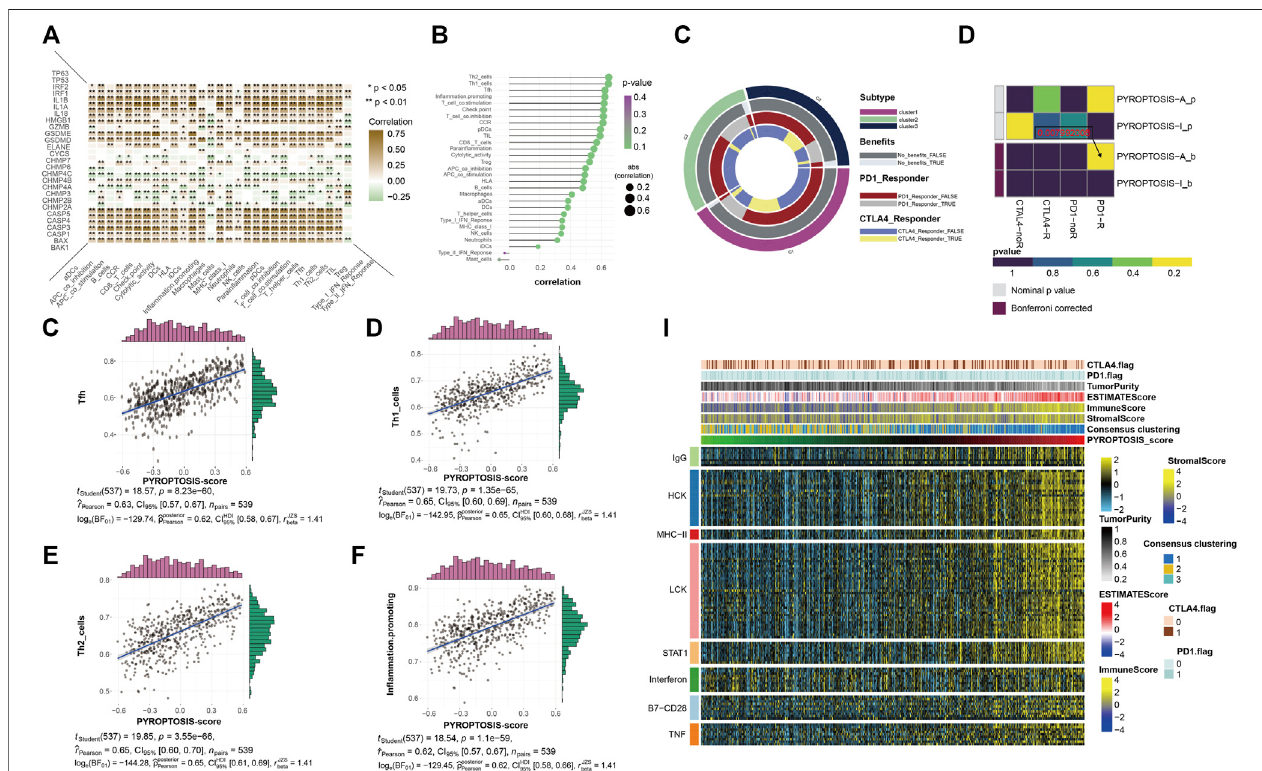
FIGURE 4 | (A) The heatmap shows the correlation between all pyroptosis-related genes and various immune in fi ltration-related indicators. The color bar on the right showsthattheclosertobrown,thegreaterthepositivecorrelation,andtheclosertogreen,thegreaterthenegativecorrelation.*representative p < 0.05,**represents p < 0.01. (B) Thebubbleplotshowsthedegreeofcorrelation.Thebubblesizerepresentsthecorrelationsizefrom0.2to0.6,andthecolorrepresentsthe p -valuefrom0.1to0.4. (C – F) The four scatter plots respectively show the correlation between pyroptosis- score and Tfh, Th1 cell, Th2 cell, and in fl ammation-promotion. (G) The ring plot shows the predicted ef fi cacy and bene fi t of three clusters of different immune checkpoint blocking therapies. (H) The heatmap shows the results of predicting the p -values obtained by comparing pyroptosis-activeand pyroptosis-inactive samplesusing PD-1 and CTLA4 treatment,and the comparison results ofthe p -values afterBonferronicorrection. (I) To identify the meta-genes of major expression vectors associated with immunotherapy, we screened the samples for 113 genes associated with 8 in fl ammatory factors. The heatmap shows the expression of these 113 genes and other immunotherapy-related scores in the KIRC